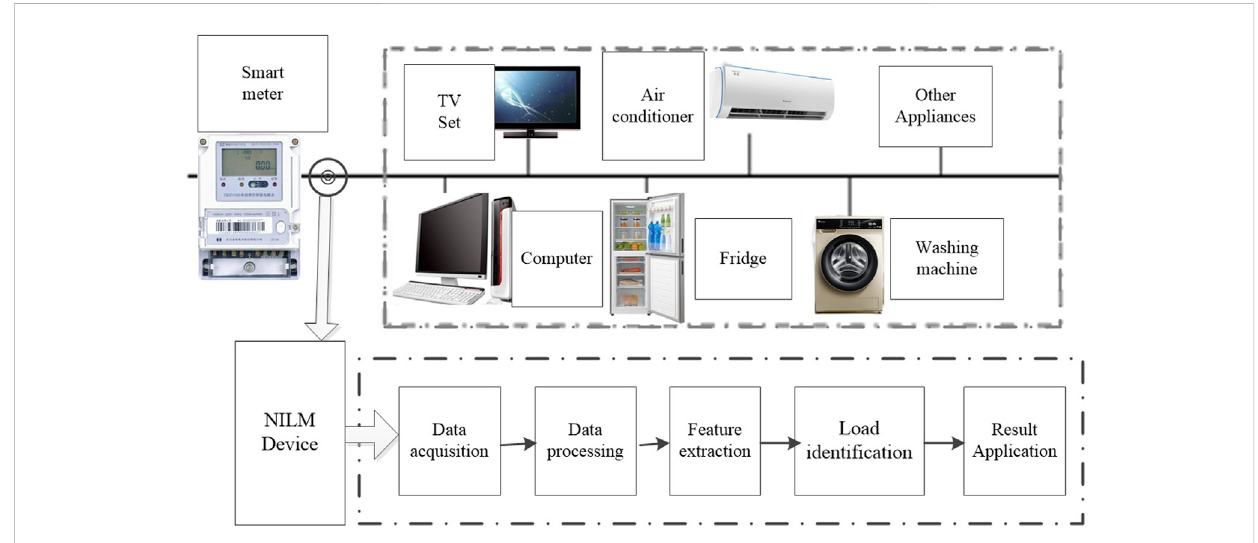
FIGURE 1 The schematic diagram of non-intrusive monitoring